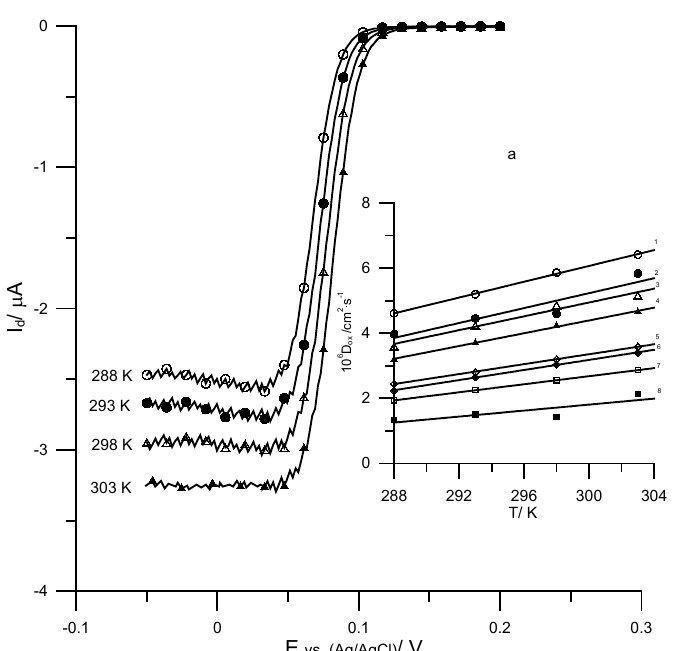
Figure 2. DC polarograms of 1×10 -3 mol dm -3 Bi(III) in 3 mol dm -3 chlorates (VII) in the presence of 1×10 -2 mol dm -3 cystine, in the studied temperature range: ( ○ ) 288 K, ( ● ) K, ( D ) 298 K, ( ▲ ) 303 K. Fig. 2a.:Temperature dependence of the diffusion coefficients D ions in 1–8 mol dm -3 chlorates (VII) in the presence of 10 -2 mol dm -3 cystine. The concentration of chlorates (VII) in mol dm -3 is indicated at each